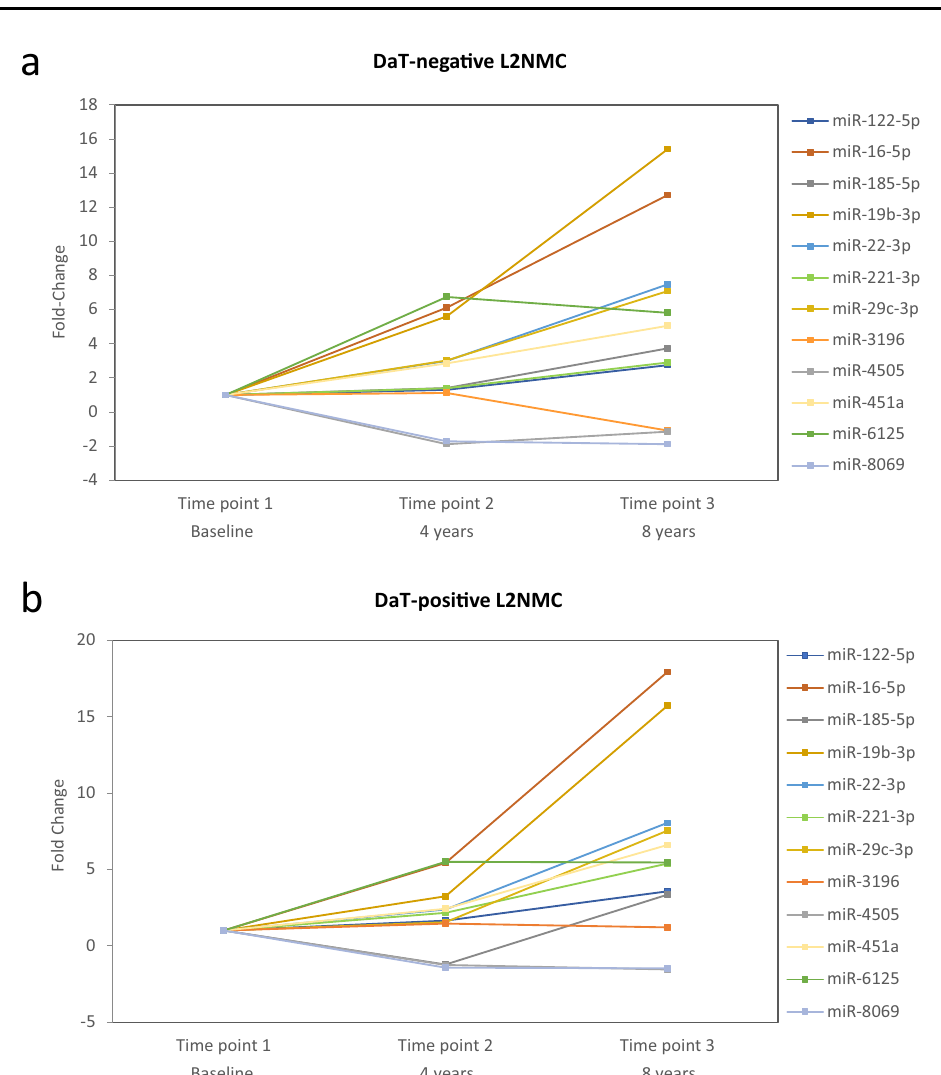
RT-qPCR analysis comparing time point 2 and 3 of DaT-negative and DaT-positive L2NMC groups with their respective baselines. DaT DaT-SPECT imaging, L2NMC LRRK2 non-manifesting carriers, L2PD LRRK2-associated PD patients, iPD idiopathic PD patients, FC fold change, Adj. p FDR multiple-test adjusted p value.